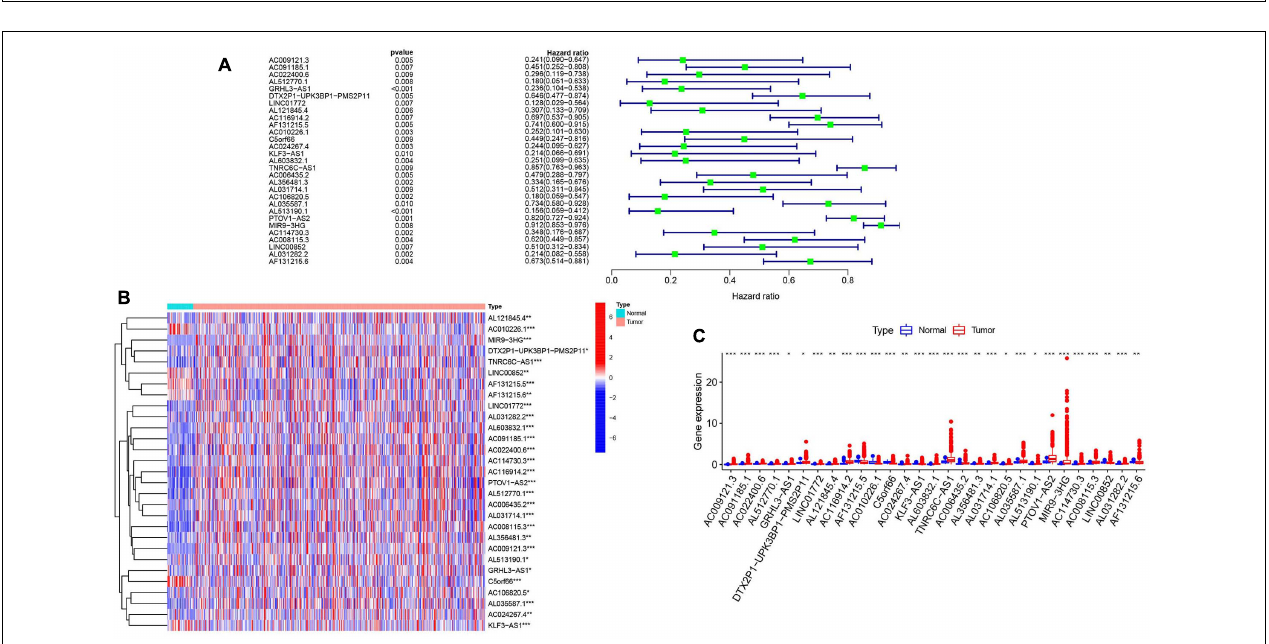
FIGURE 2 | The expression characteristics and correlations of N6-methyladenosine (m 6 A) RNA methylation regulators in head and neck squamous cell carcinoma (HNSCC). (A) Heatmap presented the overall expression of 23 m 6 A RNA methylation regulators in HNSCC tissues (T) and normal tissues (N) from The Cancer Genome Atlas (TCGA) datasets. P < 0.05 ("*"), P < 0.01 ("**"), and P < 0.001 ("***"). (B) The interaction of the m 6 A RNA methylation regulators (red) and related IncRNAs (blue).